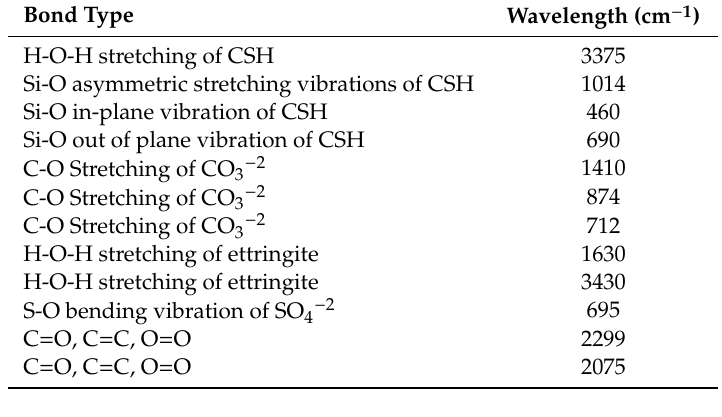
Table 2. Observed peak values in FTIR spectra of control sample. Adapted from [48].